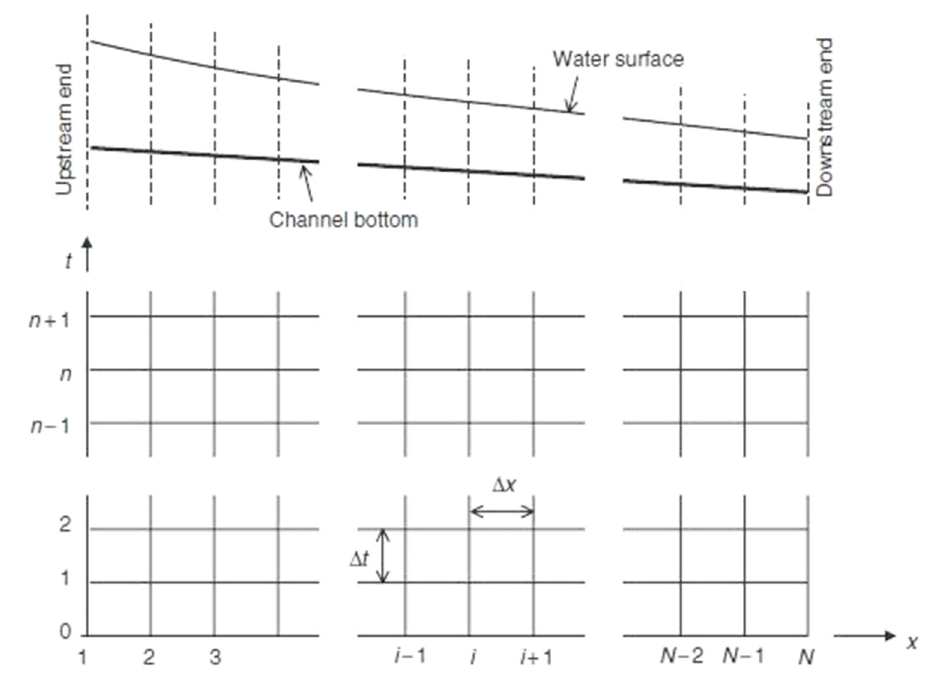
Figure 1. Computational